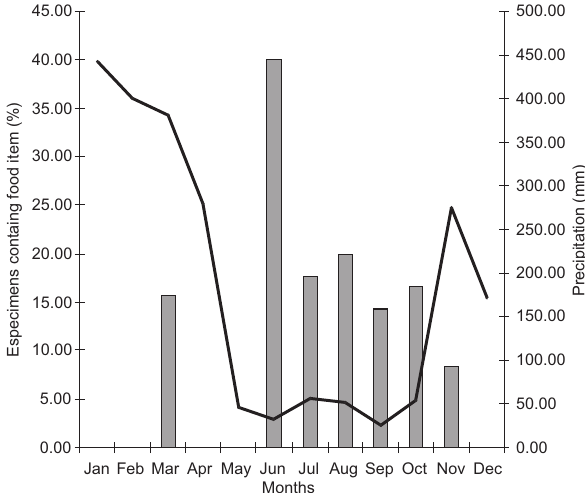
Figure 2. Relation between the numbers of food items registered in the stomachs of Anilius scytale , in percentage for the months of the year, in Brazilian